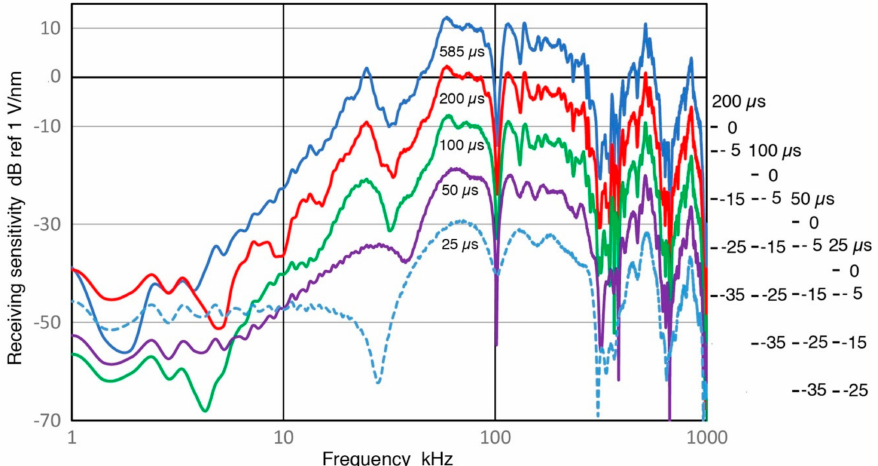
Figure 18. The same receiving sensitivity spectra of MA-Bls 40 from Figure 17, but are shown with log-frequency scale to expand the low frequency region. Each spectrum is shifted by 10 dB vertically and shifted scales shown at